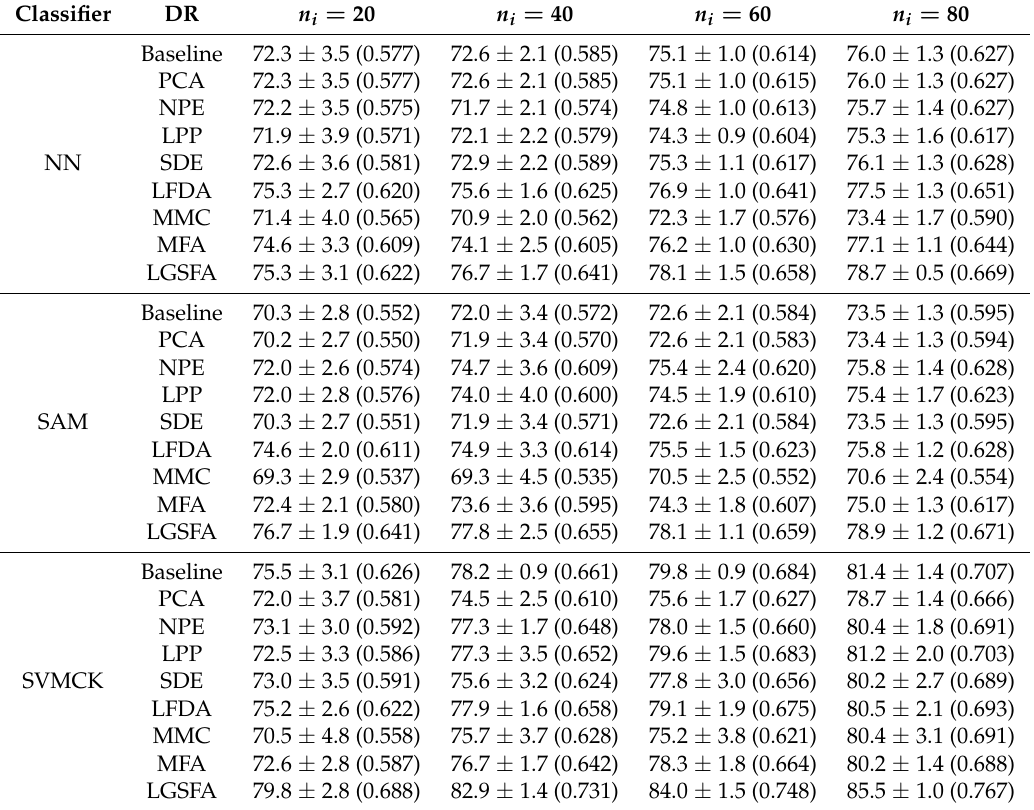
Table 5. Classification results with different numbers of training samples on the Urban data set (OA ± std (%)